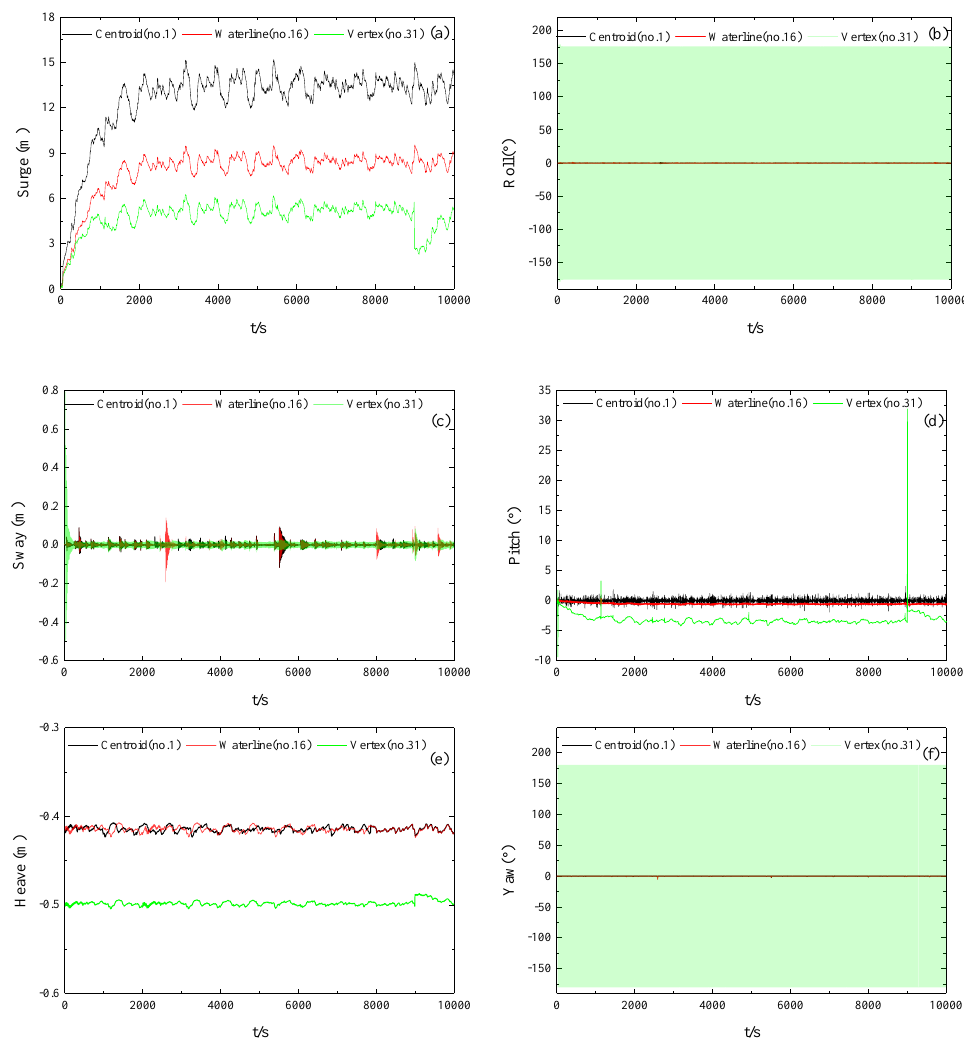
Figure 17. 6DoF time-history motion curves of floats at different mooring points. (Sub-figures: ( a ) surge motion curves; ( b ) roll motion curves; ( c ) sway motion curves; ( d ) pitch motion curves; ( e ) heave motion curves; ( f ) yaw motion curves.).